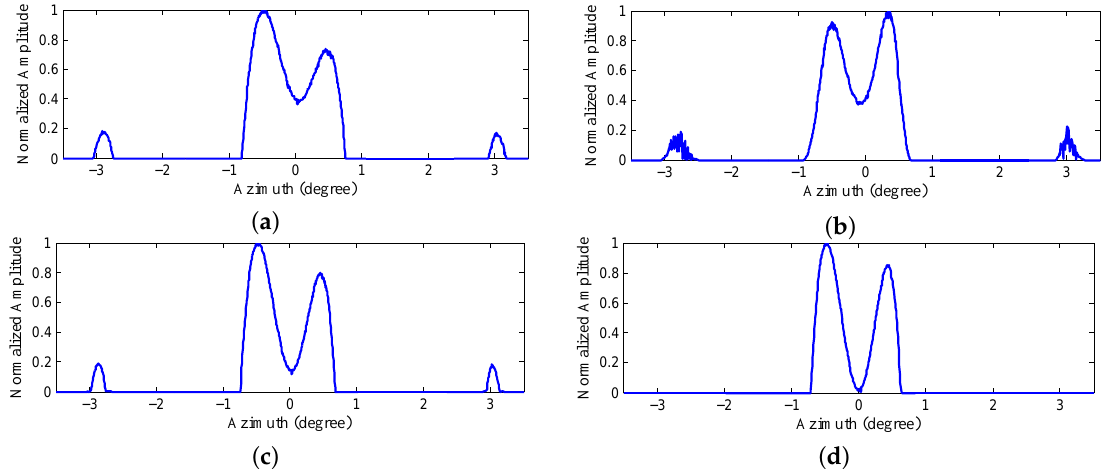
Figure 14. The profiles of the farthest corner reflectors in Figure 13 obtained by ( a ) Landweber ( b ) Richardson-Lucy (RL) ( c ) maximum a posterior (MAP) ( d ) proposed penalized maximum likelihood (PML) ( e ) proposed penalized maximum likelihood